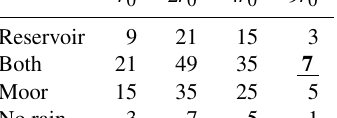
Table 1. Joint probability matrix of the 4 × 4 = 16 outcomes of rain- fall times 256, with the extreme case of 7 / 256 shown in bold under- lined. The rows show P (location) and columns P (amount), with both summing to the imposed discrete distribution (3, 7, 5, 1 )/ 16. Since the P (location) and P (amount) are independent, the joint probability is their product.